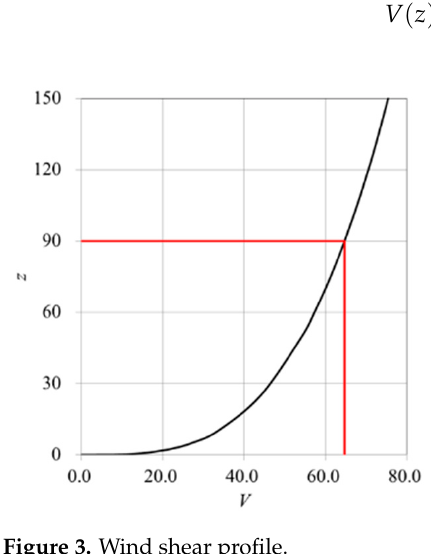
Figure 4. Wind measurements. ( a ) Gust factor; ( b ) turbulence intensity; ( c ) wind speed correlation.